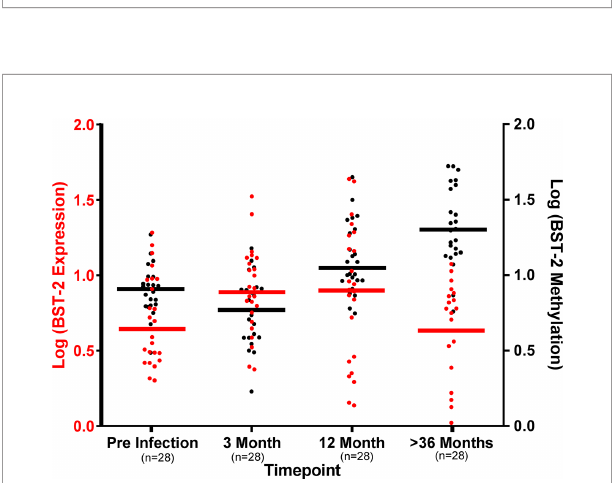
( Figure 4 ). Overall, these results suggest that DNA methylation is not the sole contributor to BST-2 expression variation.